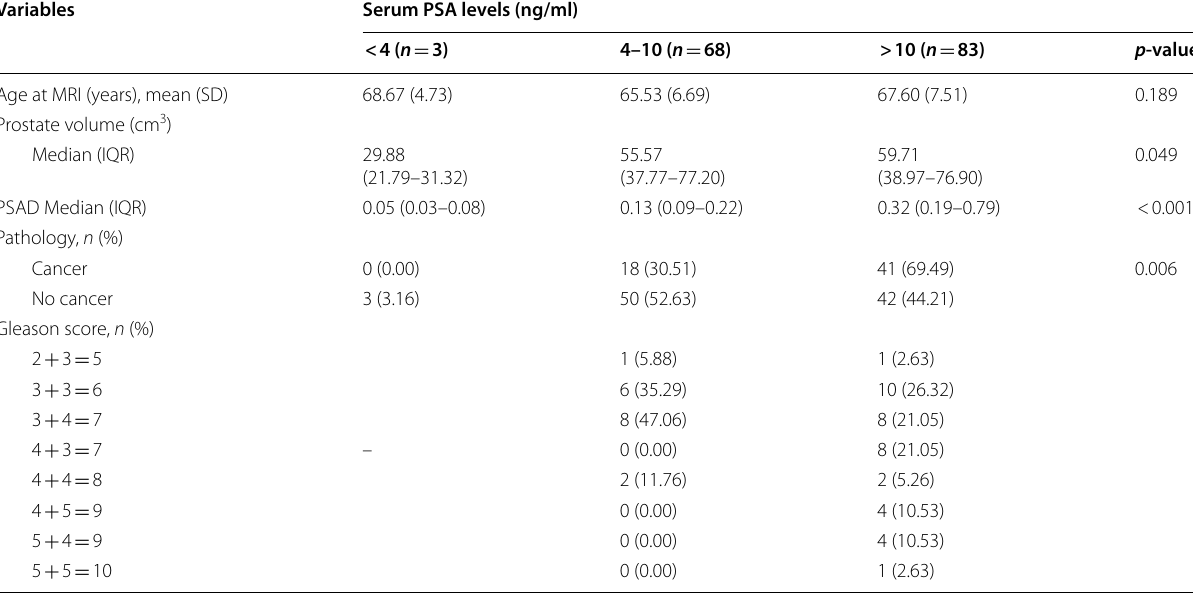
Table 4. The receiver operating characteristic (ROC) curves of PSAD in identification of prostate cancer are shown in Fig. 2. Table 2 Demographic data of patients with serum PSA levels < 4 ng/ml, 4–10 ng/ml, and > 10 ng/ml Variables Serum PSA levels (ng/ml)